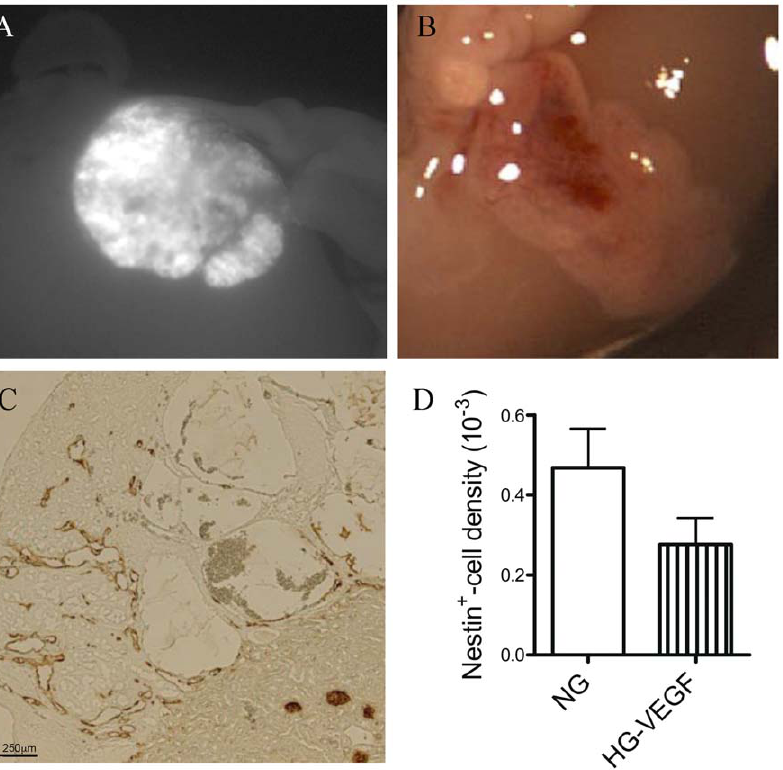
Figure 5. Over-expression of VEGF using RCAS retrovirus. Embryonic chick pancreas was infected with RCAS-GFP just before grafting. GFP was only and strongly expressed in the graft (A). In B, a photograph of a RCAS-VEGF-infected and grafted pancreas after 2 weeks hyperglycaemia showed the presence of blood filled spaces. In C, nestin immunohistochemsitry in VEGF-over-expressing and grafted pancreas after 2 weeks in hyperglycaemic conditions and in D, morphometry analyses of nestin immunohistochemistry (n=4).